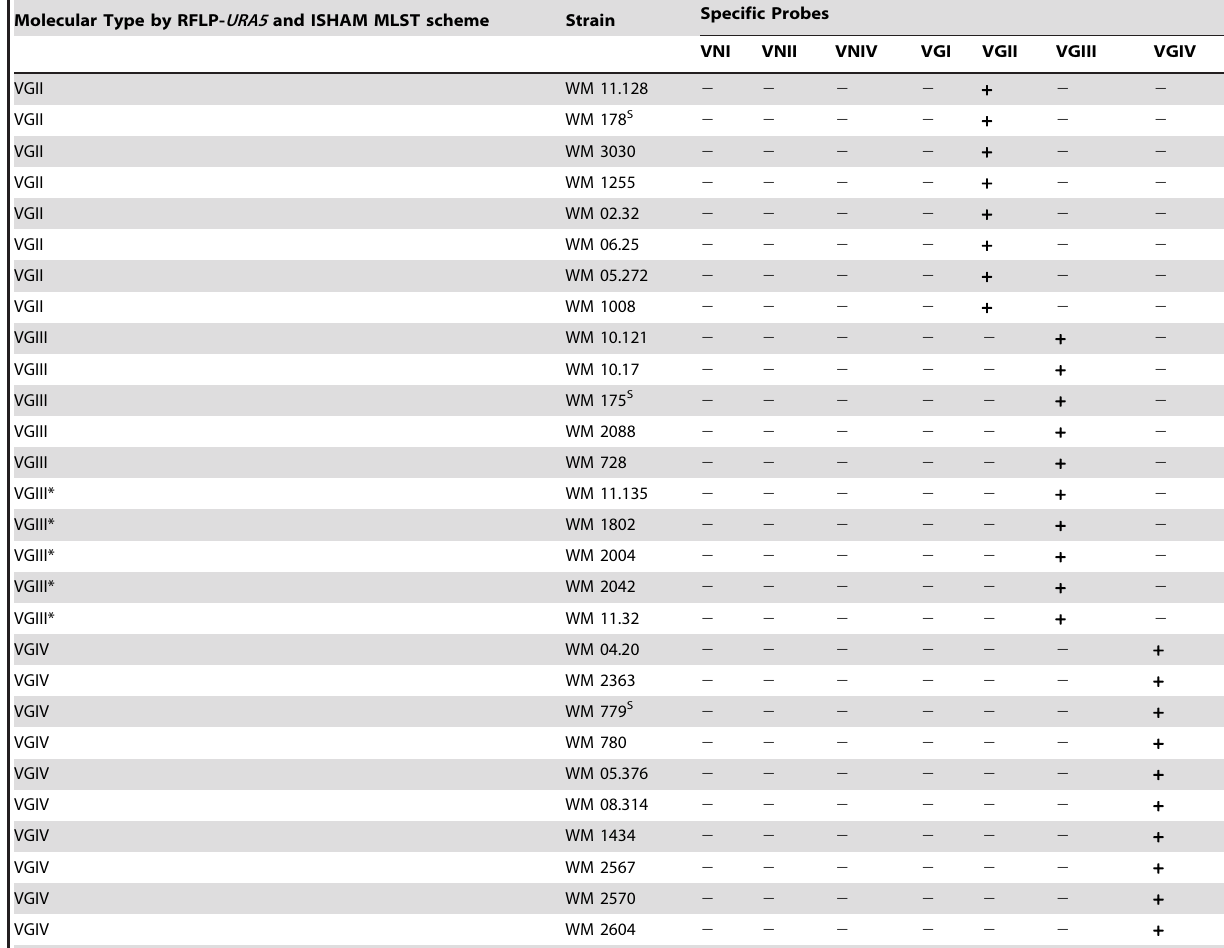
Molecular Type by RFLP- URA5 and ISHAM MLST